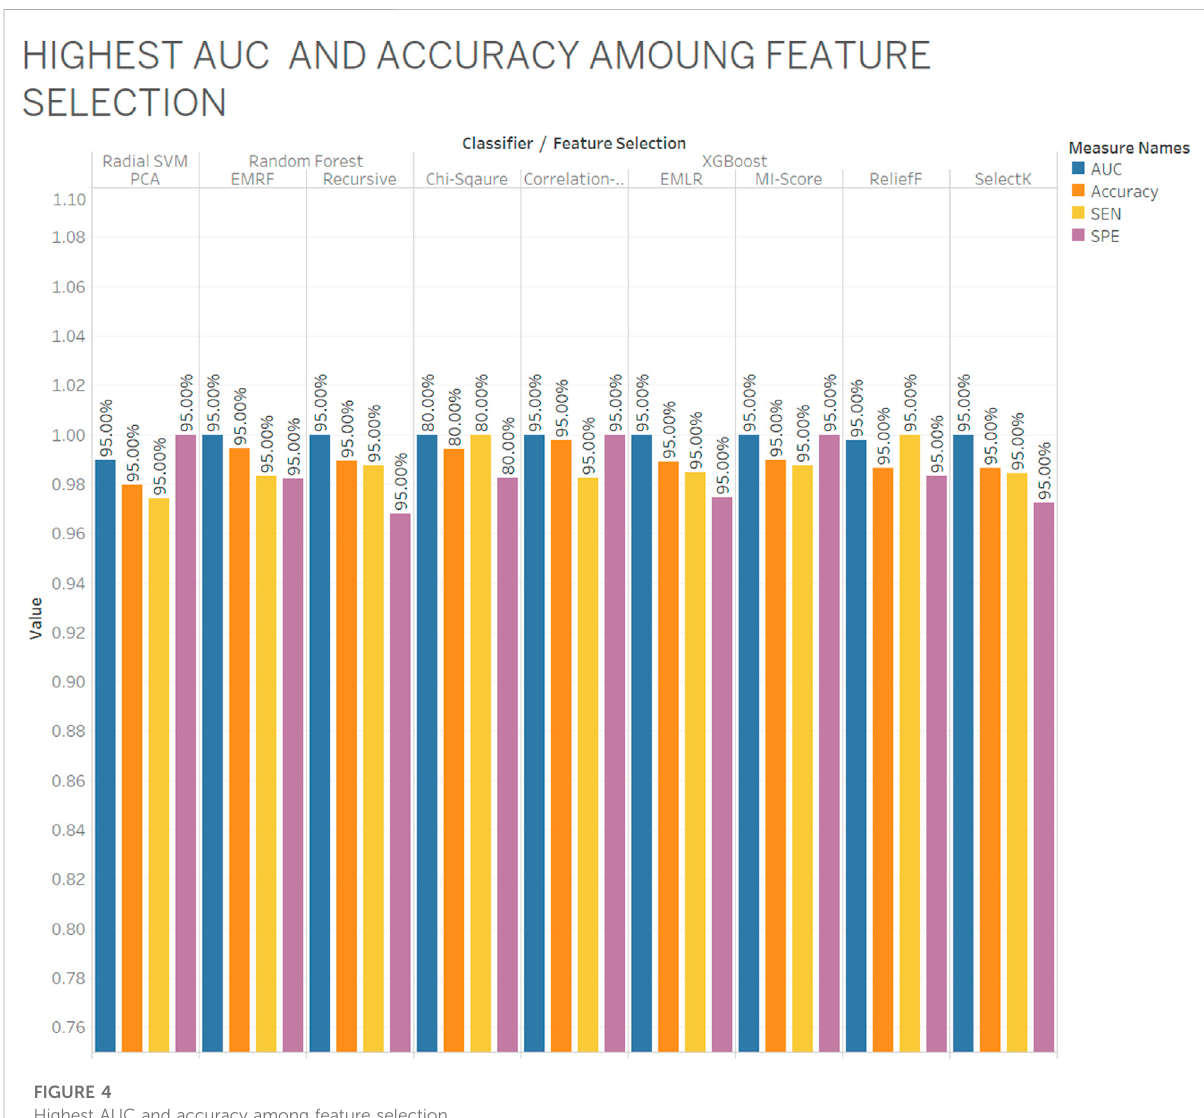
FIGURE 4 Highest AUC and accuracy among feature